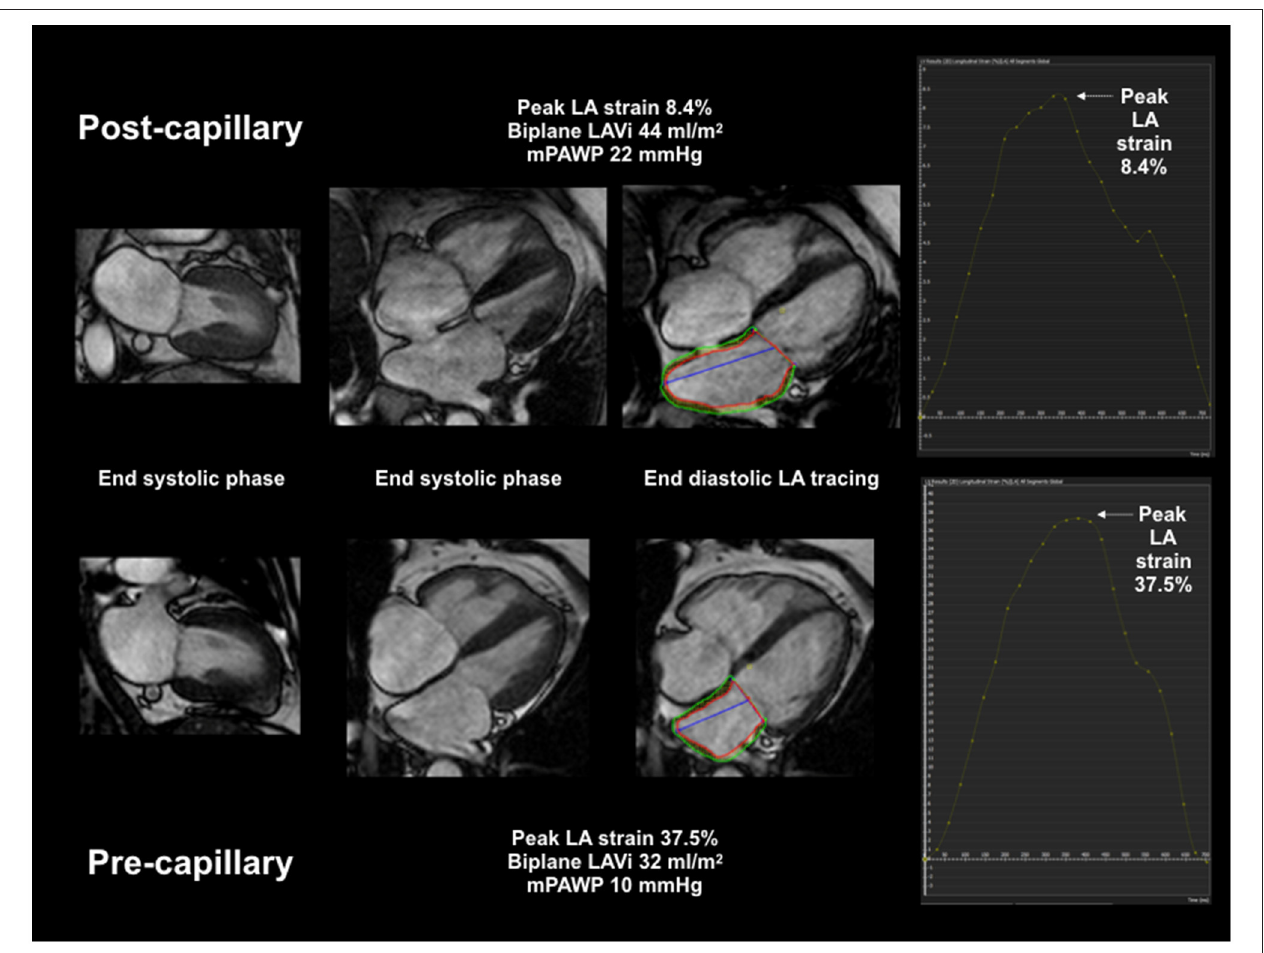
FIGURE 1 | CMR LA volumetric and deformation assessment. Combined CMR LAVi and peak LA strain multivariate AUC 0.98 for post-capillary PH